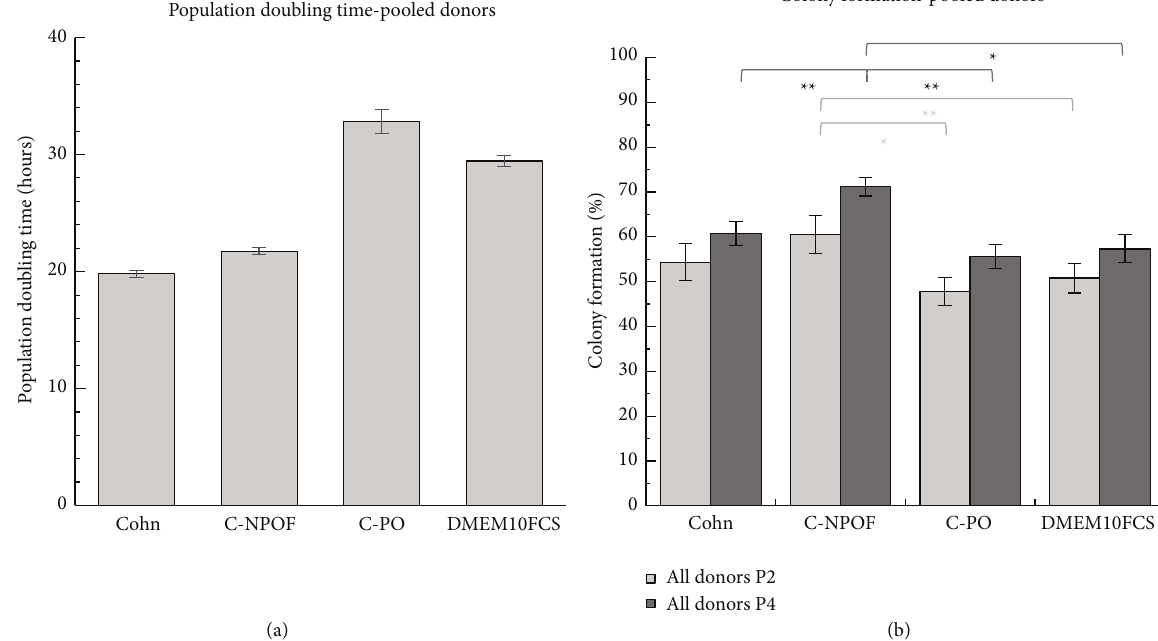
Figure 2: Growth and colony forming ability of donor MSCs. Pooled results represent the averages of three separate donors. Donor MSCs were grown in PPRF-msc6 with various albumins or in DMEM 10% FCS for two passages before growth analysis in a 96-well plate based assay. All population doubling times were significantly different to each other ( 𝑃 < 0.01 ) and were calculated from cell numbers at 24 and 72 hours (a). Colony forming ability was measured following similar growth conditions for either 2 or 4 consecutive passages (b). Results are combined from 3 separate donors and experiments repeated at least twice. Error bars represent standard error of the mean, ** indicates a 𝑃 value of < 0.01, and * indicates a 𝑃 value of < 0.05.